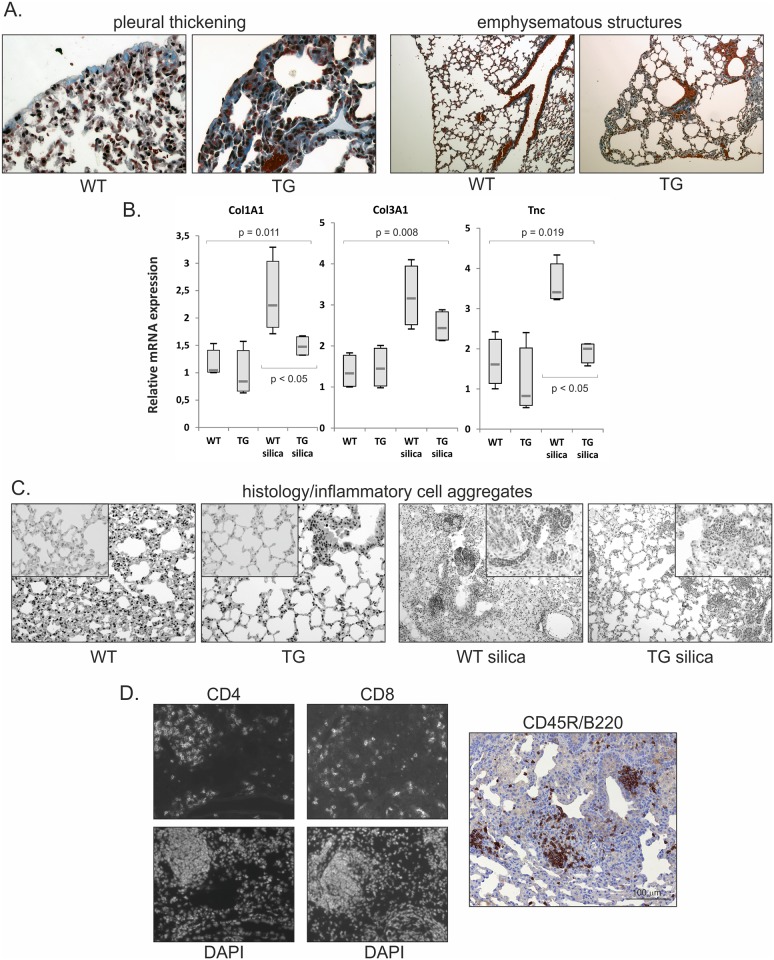
Reduced amount of inflammatory cell aggregates in gremlin-1 transgenic lung.A. Histological sections of gremlin-1 transgenic and wild type lung showing pleural thickening (original magnification 400x) and alveolar space enlargement (original magnification 100x) at 6 months of age. Results of histological scoring are presented in Table 1. B. Mice were treated with silica for 2 months and sacrificed at 6 months of age. Collagen 1 (Col1A1), collagen 3 (Col3A1) and tenascin-C (Tnc) mRNA expression levels analyzed from lung tissue RNA using quantitative RT-PCR (n = 4). The results are presented as box blots. The p values were calculated using the Kruskal-Wallis test or the Mann-Whitney U-test when comparing two groups. WT = wild type mice; TG = gremlin-1 transgenic mice. C. Representative histological pictures showing decreased amount of inflammatory cell aggregates in silica-treated gremlin-1 transgenic mice. Original magnification 200x, inset original magnification 400x. D. Immunofluorescence staining of wild type frozen lung tissue sections using CD4 and CD8 T-cell markers. DAPI staining was used to visualize the nuclei. Immunohistochemical staining of CD45R/B220 (brown color) is shown on the right.